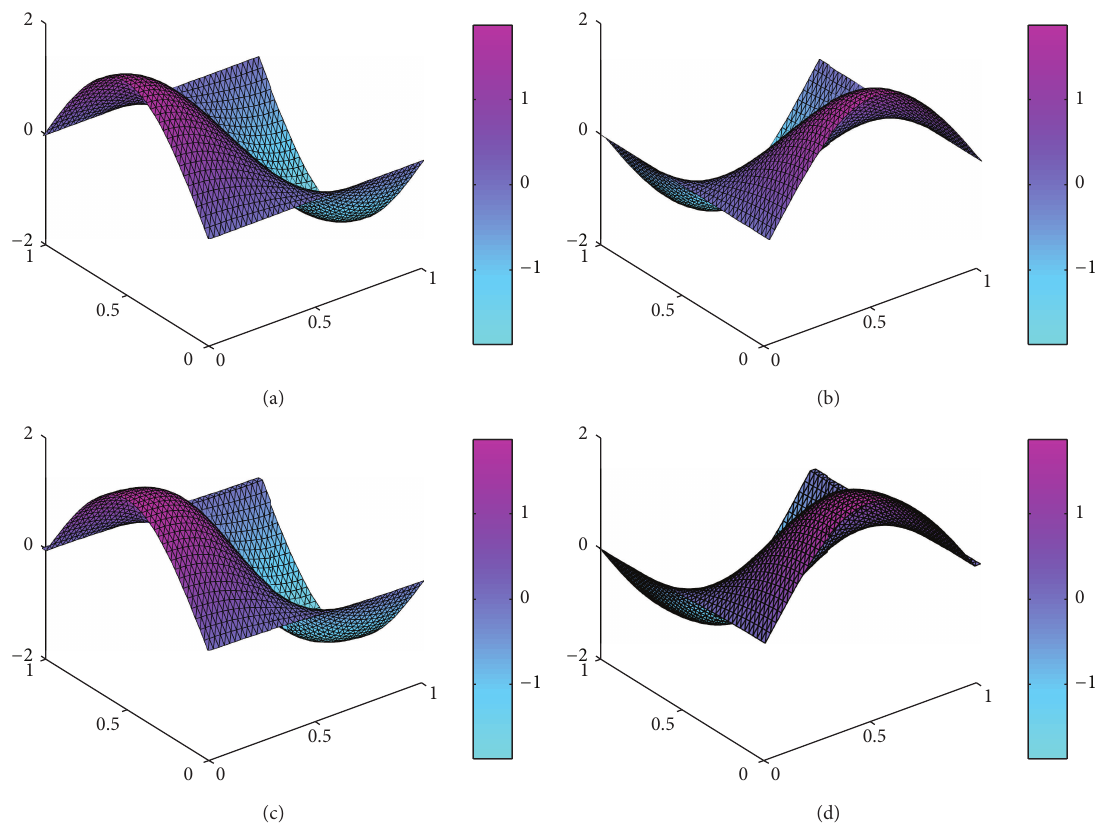
Figure 2: The figures of exact solution p = (𝑃 1 , 𝑃 2 ) and numerical solution p ℎ = (𝑃 ℎ1 , 𝑃 ℎ2 ) at 𝑡 = 1.0 ((a), (b) for p and (c), (d) for p ℎ ).